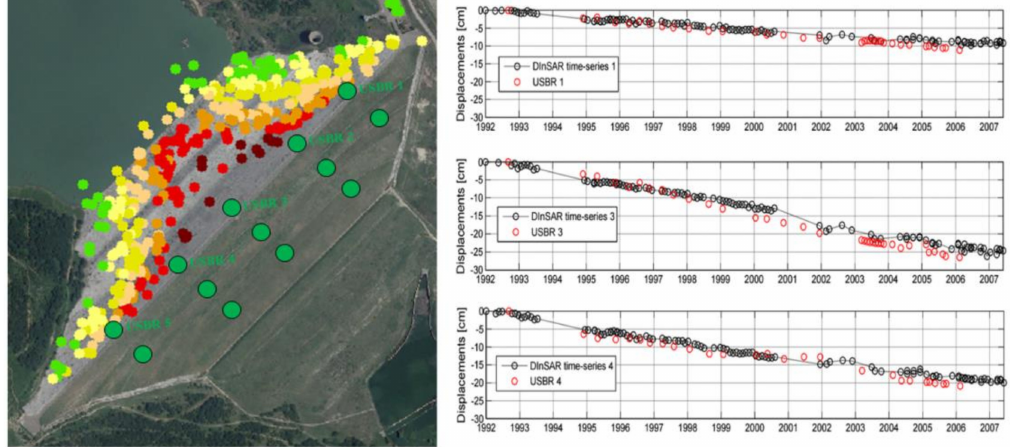
Figure 6. On the left, persistent scatterers extracted by using A-DInSAR techniques at the Genzano di Lucania earth dam (Italy) [23]. The colour of each point indicates the vertical velocity (from green to red). On the right side, the time series (1992–2007) of vertical displacements in correspondence of three persistent scatterers selected on the dam crest in the proximity of three topographic benchmarks (green circles with black contour). The acronym USBR stands for United States Bureau of